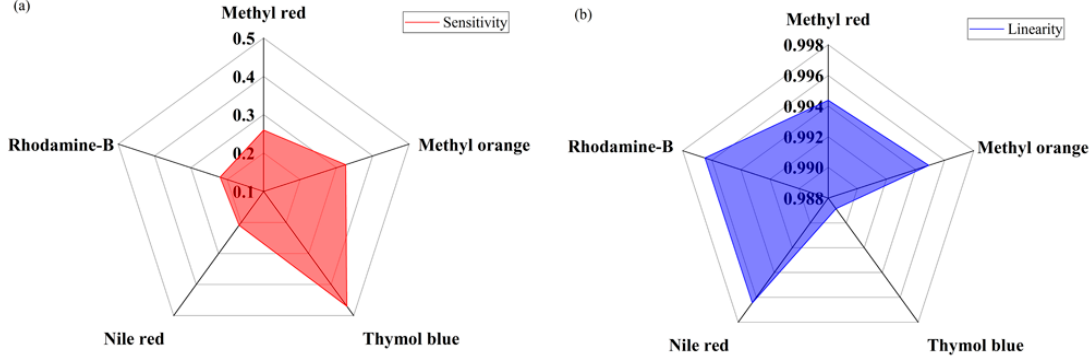
Figure 9. Performance of the proposed optical-fiber pH-sensing system: ( a ) sensitivity; and ( b ) linearity.